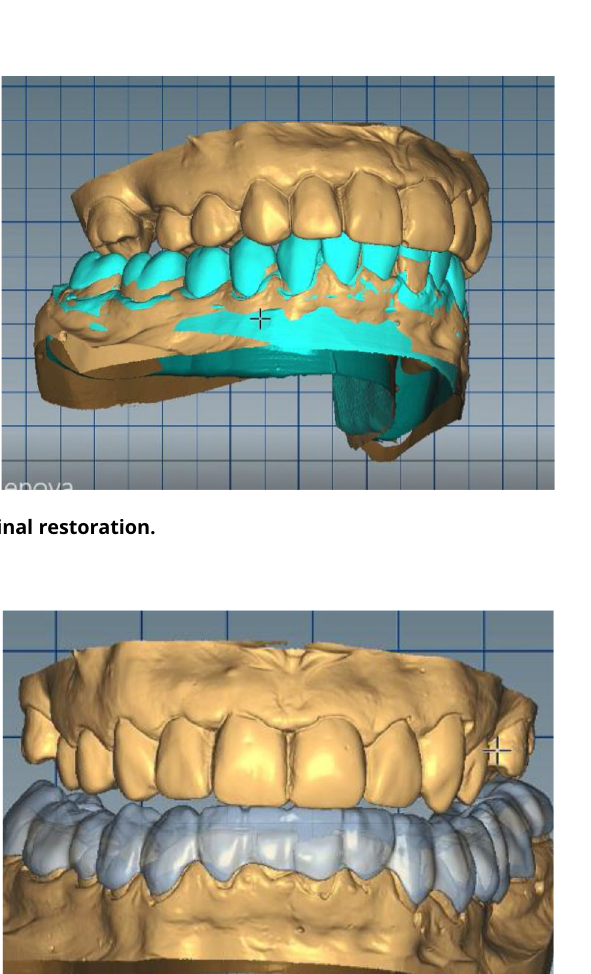
Figure 12. New position of the lower jaw.